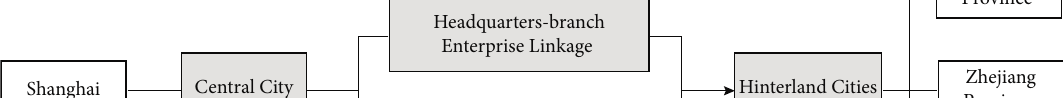
Figure 1: Map of the study area.